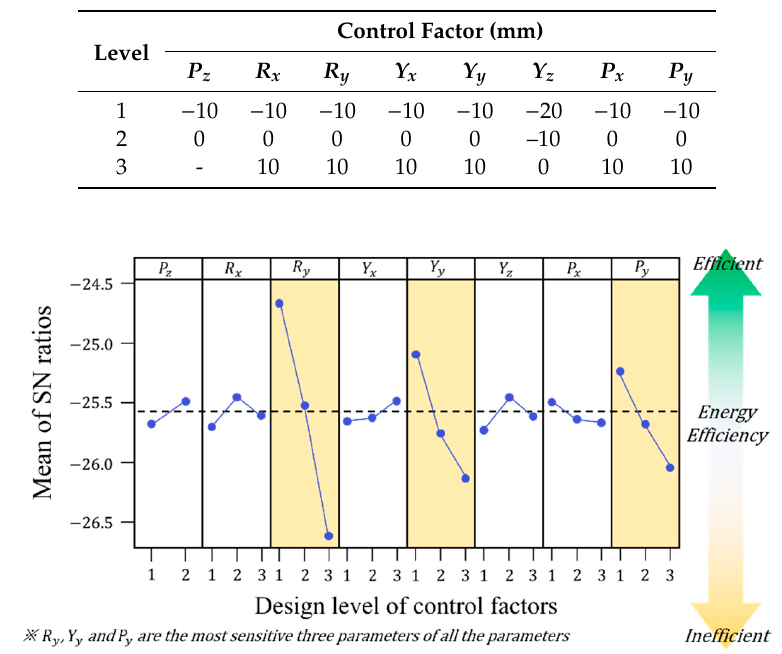
Figure 5. Signal-to-noise ratios (SNRs) of the eight parameters during the first experiment. The three most influential factors are highlighted in Table 1. Levels of control factors for the first experimental set.